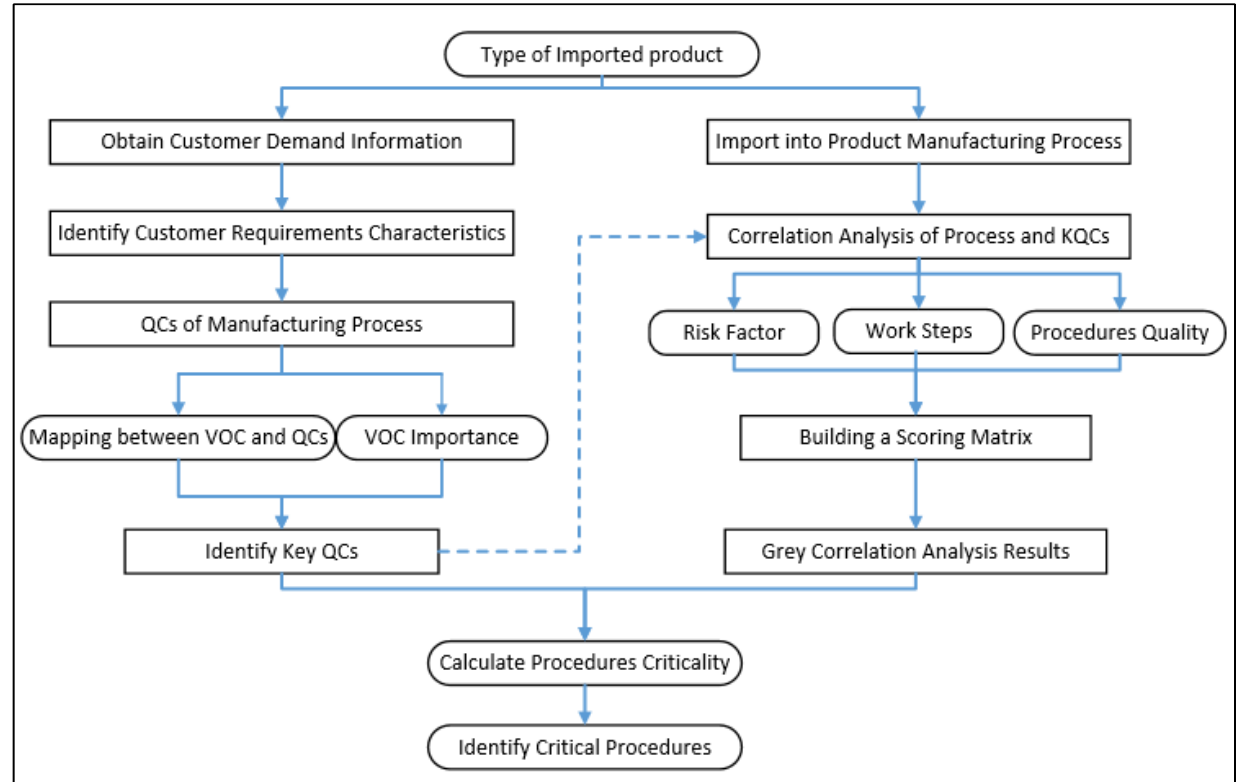
Figure 1. Research idea and structure diagram.